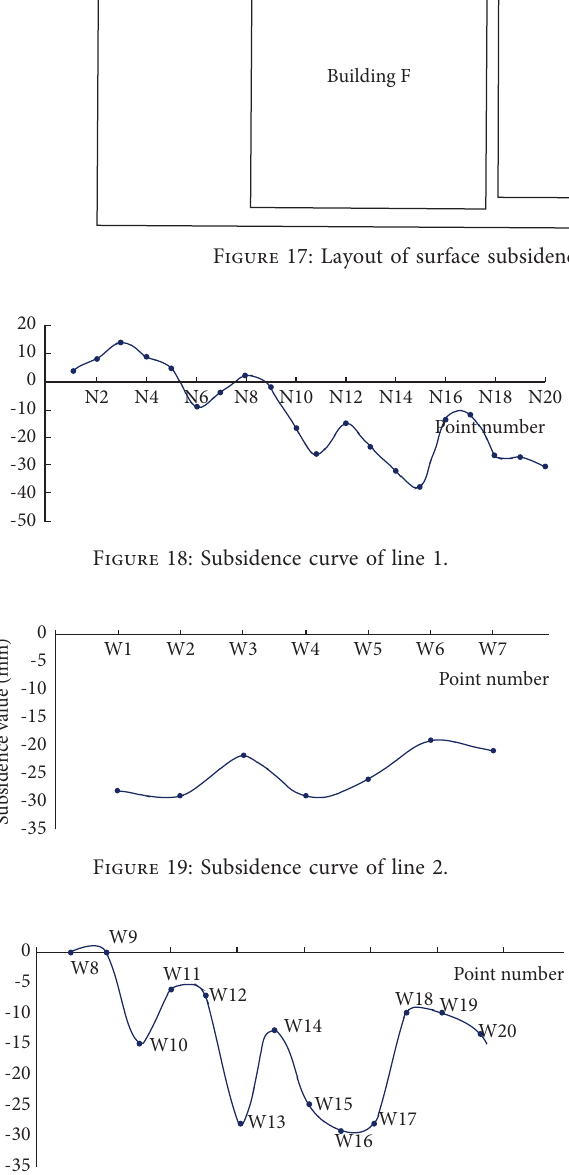
Figure 20: Subsidence curve of line